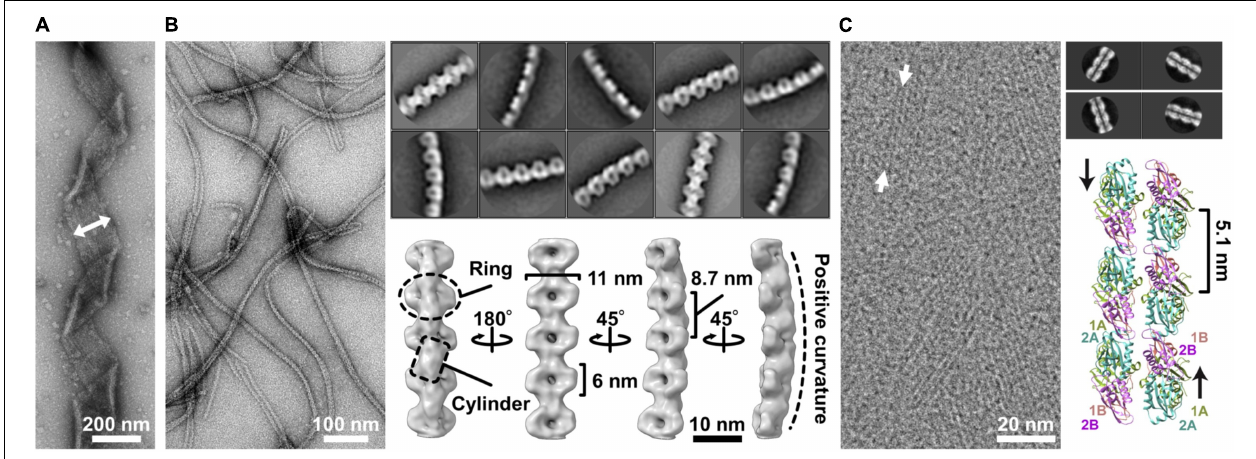
FIGURE 2 | Ribbon components. (A) Negative staining electron microscopy (EM) of the ribbon. The ribbon width is 150 nm long and is indicated by the two-headed arrow. (B) Structure of the fibril filament. Negative staining EM of the isolated fibril filament (left). Two-dimensional class averages derived from the electron micrographs of fibril filaments (right upper). The three-dimensional structure of the fibril filament (right lower). A ring and a cylinder are marked by an oval and a box, respectively. The filament has 8.7-nm periodicity along the axis and positive curvature as marked by a broken line. (C) CryoEM image of Spiroplasma citri SMreB5 filament (left). Averaged image of the double-stranded MreB filament (right upper). A model of double protofilament of S. citri MreB5 generated by superposing the structure of S. citri SMreB5 (PDB ID: 7BVY) on Caulobacter crescentus MreB (4CZE). This panel was reorganized from a previous article (Harne et al., 2020a) with